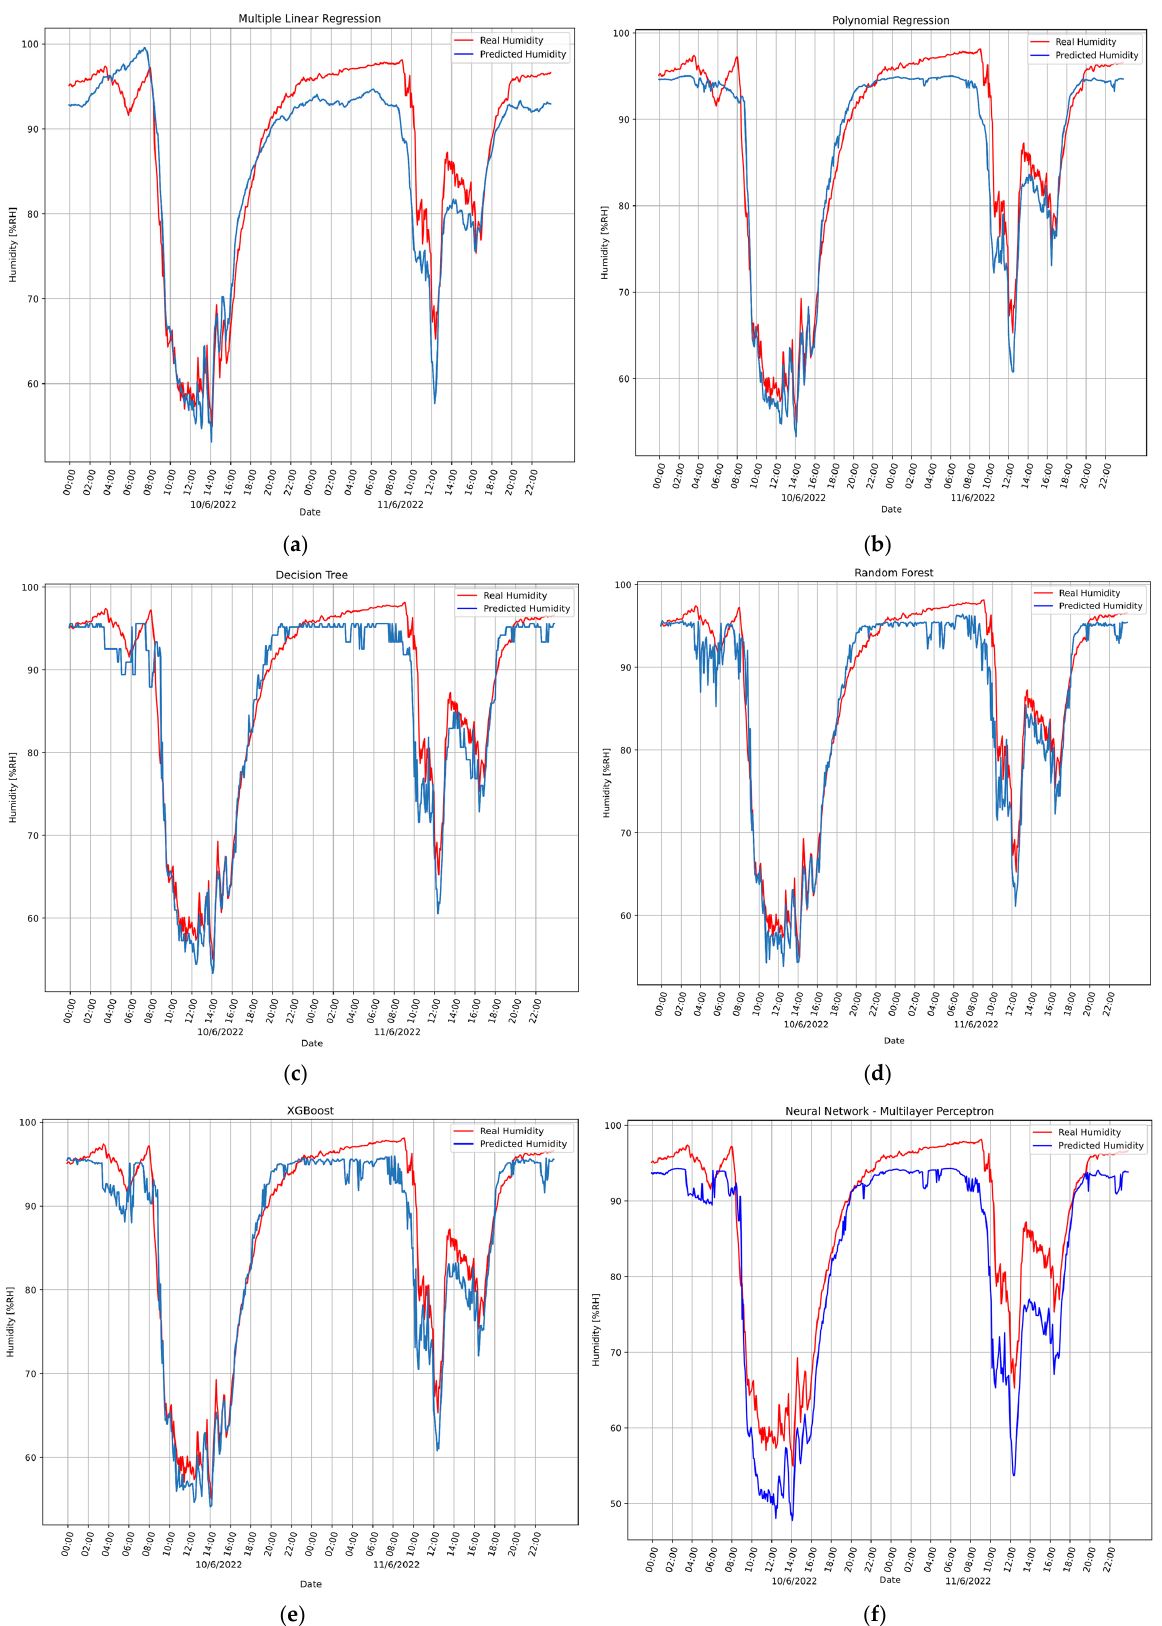
Figure 6. Techniques for relative humidity forecasting: ( a ) Multiple linear regression, ( b ) Polynomial regression, ( c ) Decision tree, ( d ) Random forest, ( e ) XGboost, ( f ) Multilayer perceptron neural net- work.